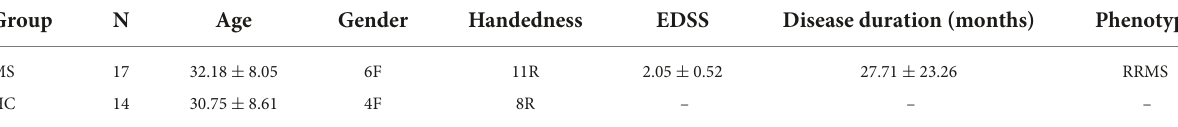
TABLE 1 Demographic data of the participants.